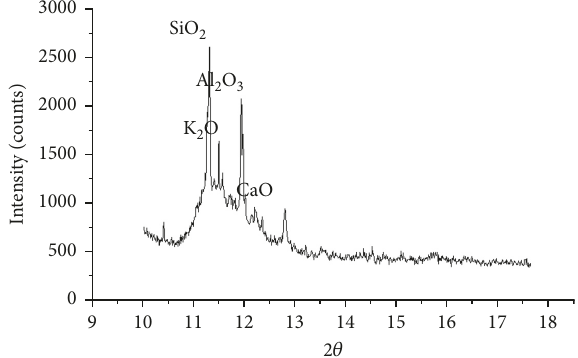
Figure 4: X-ray diffraction spectrum of the Quarry waste used (own